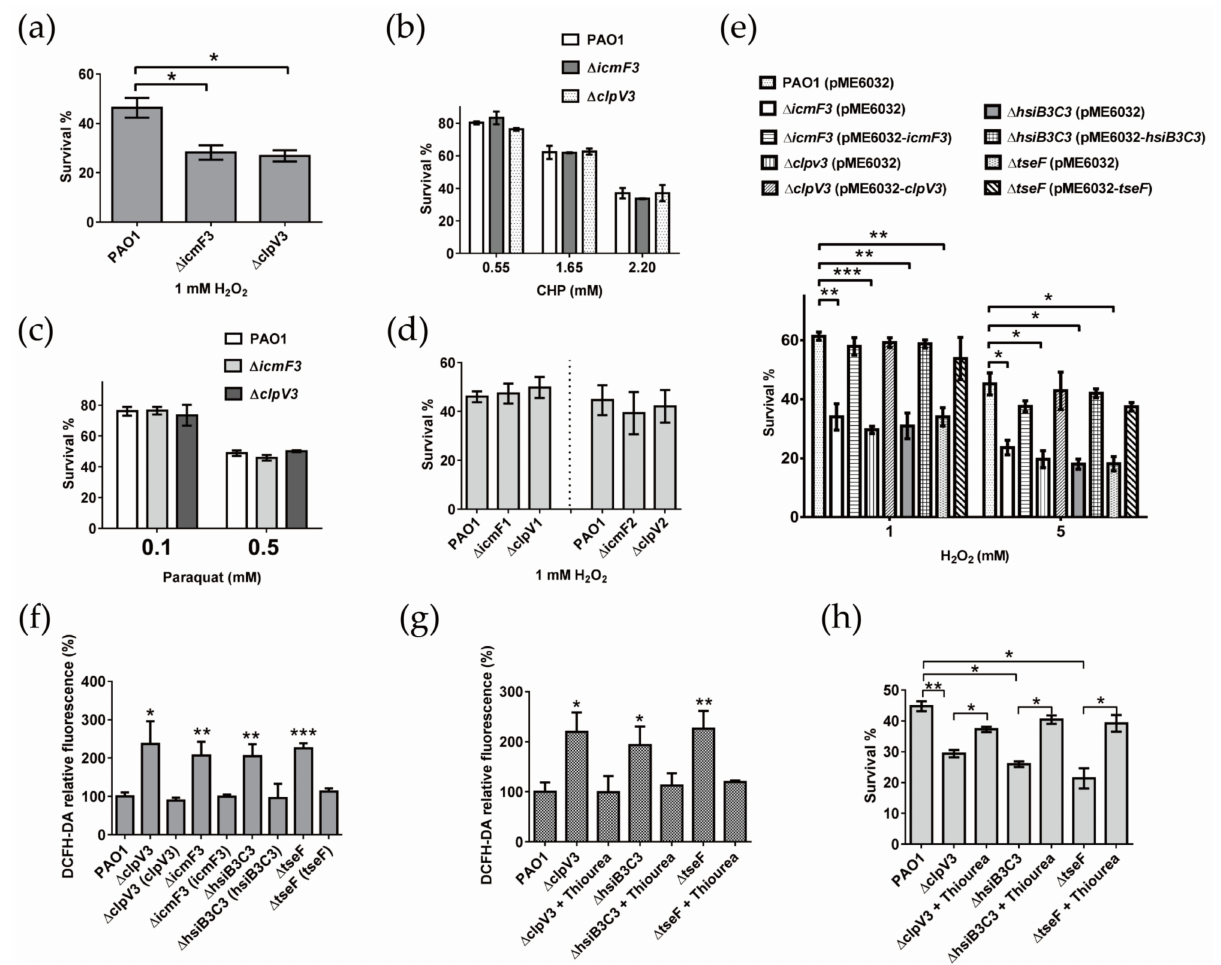
Figure 2. T6SS plays an important role in the H 2 O 2 stress response. ( a – d ) Bacterial strains grown to the stationary phase were exposed to H 2 O 2 , CHP, or paraquat for 1 h, and the viability of the cells was determined. All of these assays were performed in triplicate at least three times. * denotes p < 0.05. ( e ) Bacterial strains grown to the stationary phase were exposed to H 2 O 2 for 1 h, and the viability of the cells was determined. All of these assays were performed in triplicate at least three times. * denotes p < 0.05, ** denotes p < 0.01, and *** denotes p < 0.001. ( f ) Relative intracellular levels of ROS were measured in the stationary-phase planktonic bacteria grown in a TSB medium under H 2 O 2 stress. The cells were stained with DCFH-DA. The relative levels of fluorescence (excitation = 485 nm; emission = 535 nm) were normalized to the wild-type level under the same conditions. The data for at least three independent experiments were pooled, and the means are shown. The error bars represent the standard deviations. * denotes p < 0.05, ** denotes p < 0.01, and *** denotes p < 0.001 (compared to wild-type). ( g ) Reduction of cellular ROS in the mutants by thiourea. The compound was added to the bacterial cells subjected to H 2 O 2 stress, and the levels of ROS were measured. ( h ) Thiourea (150 mM) was added to bacterial cells under H 2 O 2 stress, and their survival rates were determined. The data shown are the average of three independent experiments; and the error bars indicate the SD of the three independent experiments. * denotes p < 0.05, and ** denotes p <